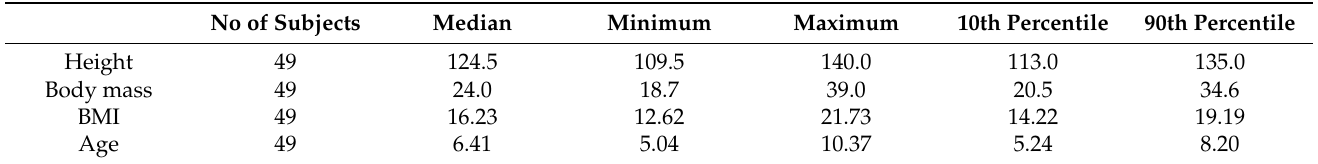
Table 1. Demographic characteristics of the group.